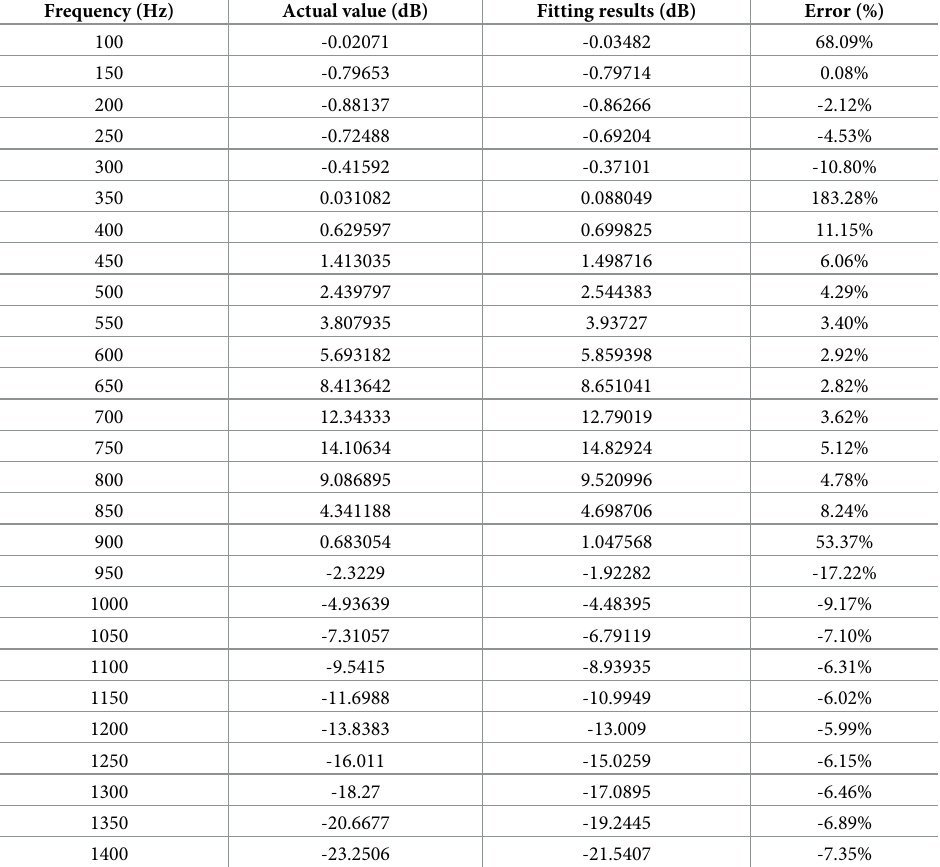
Table 7. Fitting results of the amplitude-frequency response of CVT with a speedy saturation